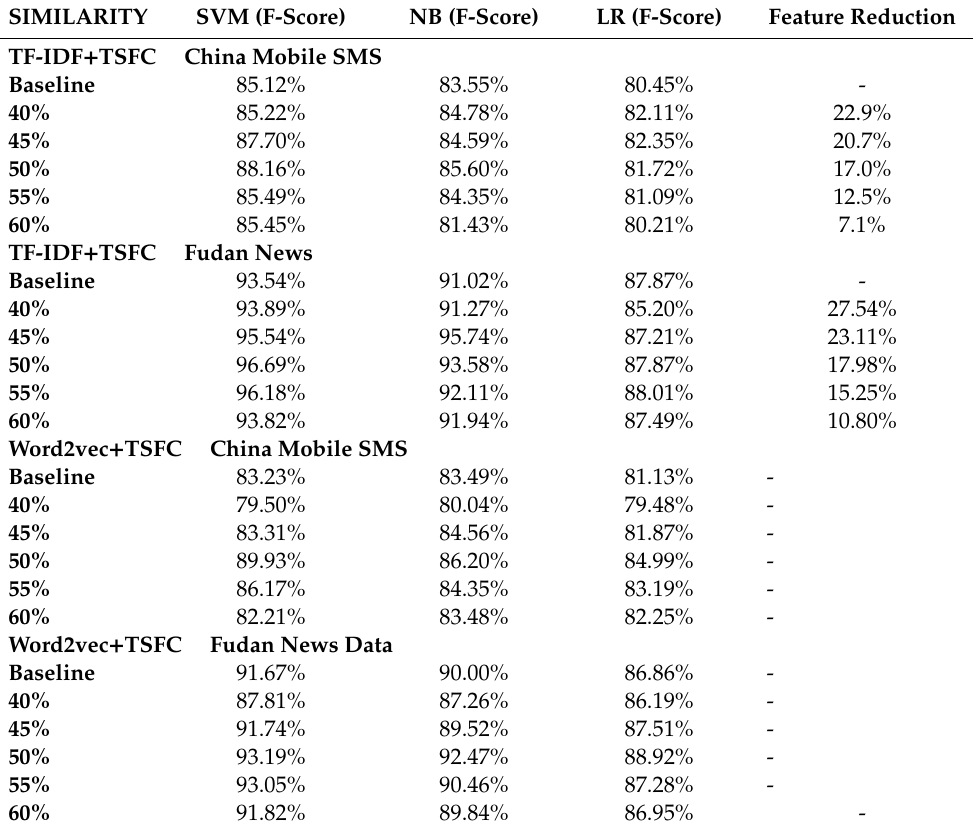
Table 4. Result of classification